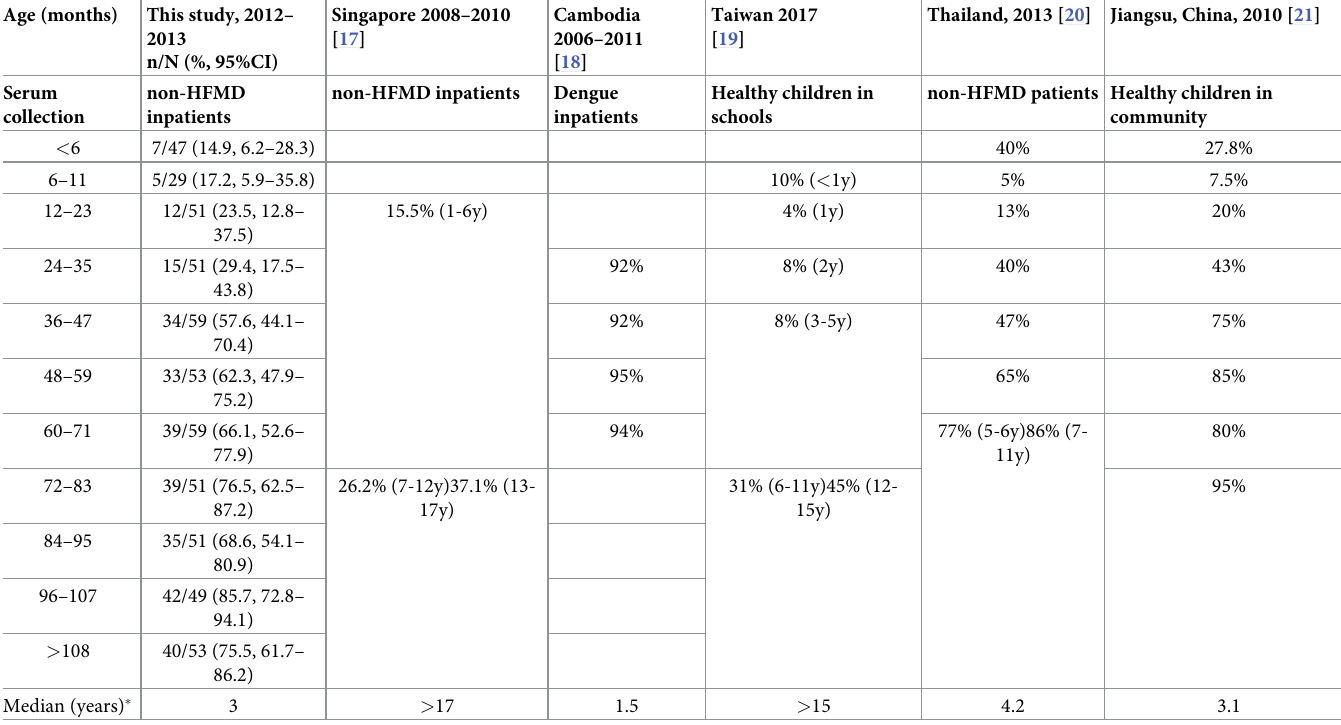
Table 1. Seroprevalence of EV71 Neutralizing Antibody in HCM City, Vietnam, 2012–2013 (n = 553), compared with some Asian countries.